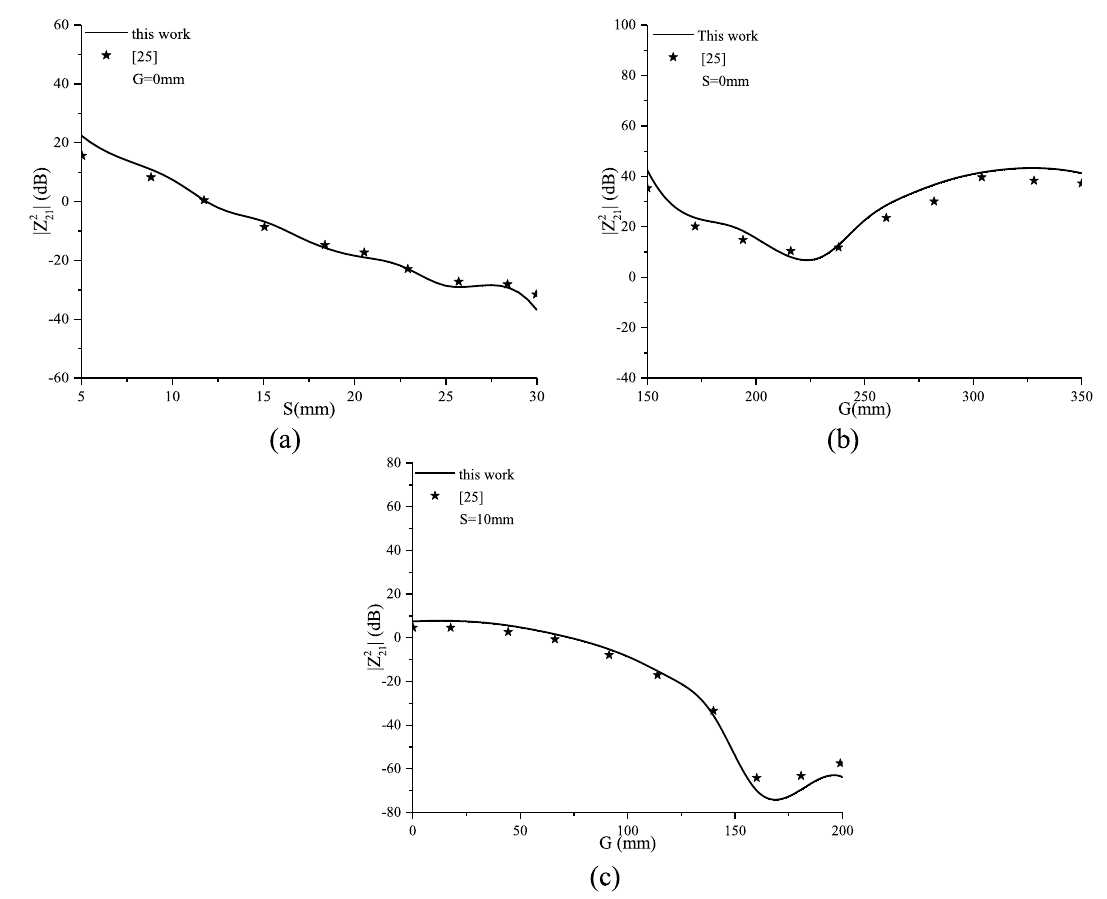
Figure 6. Isotropic mutual coupling of printed dipoles, ( a ): broadside, ( b ): collinear, and ( c ): echelon configurations.